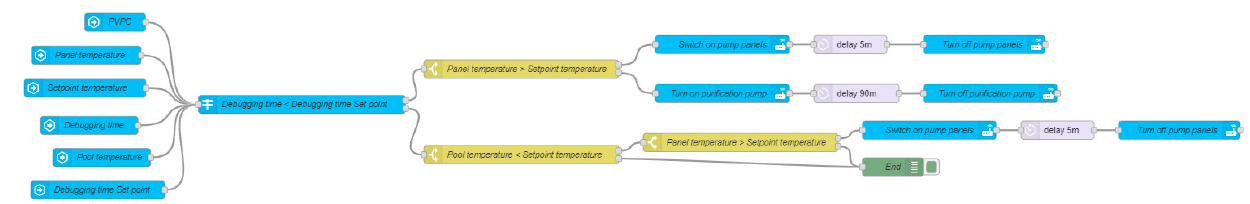
Figure 6. Optimization flowchart of the solar collector pump and the purification pump.